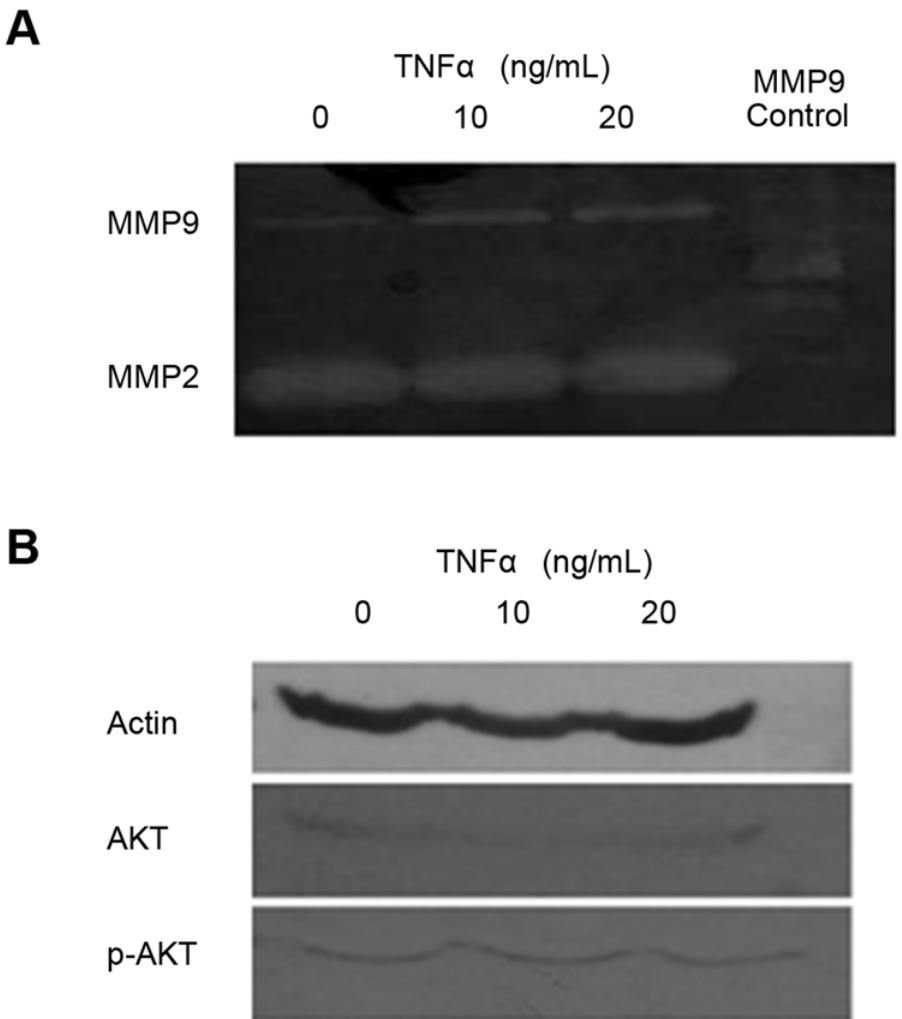
Fig 11. Gelatin zymography and Western blot analysis of F3Y cells induced by TNF α . 0, 10, or 20 ng/mL TNF was added to each culture. Purified MMP9 protein was used the MMP9 control. (A) Gelatin zymography was performed on the conditioned medium and (B) western blot was performed on the cell